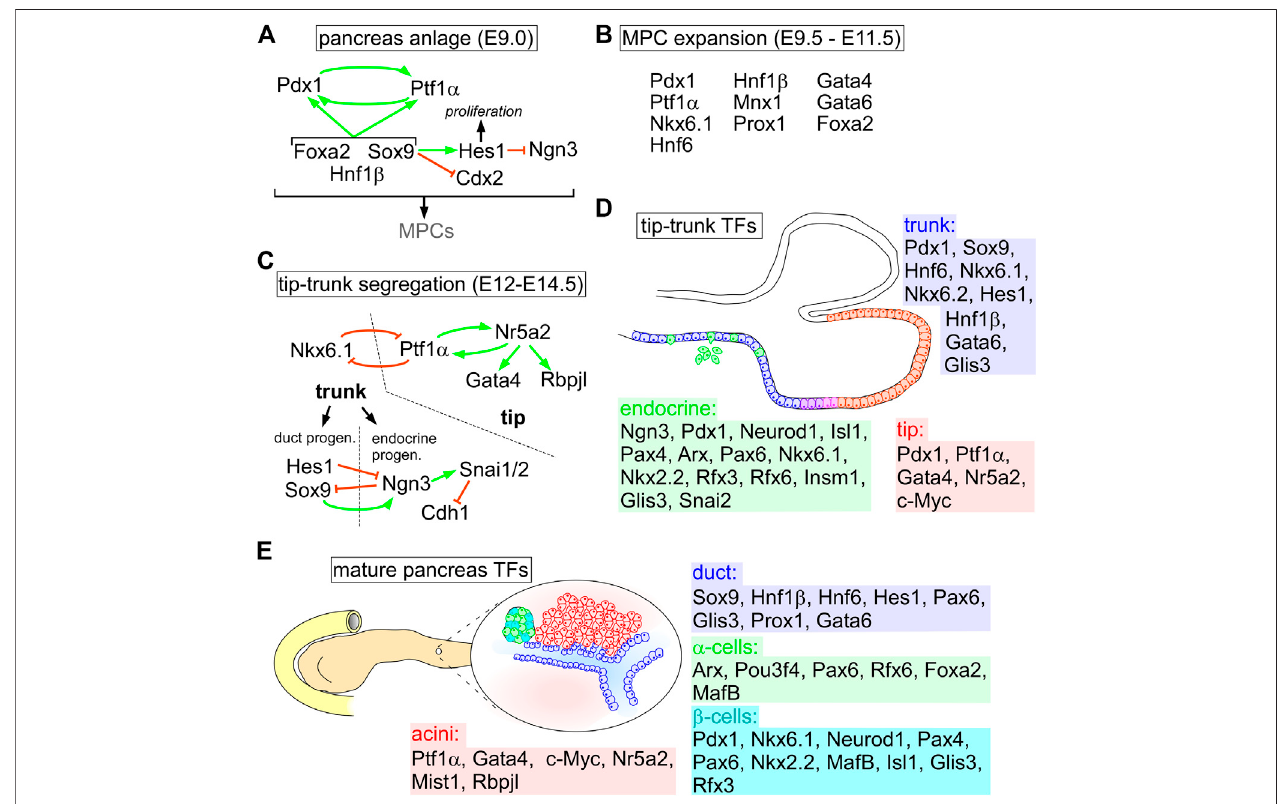
FIGURE 1 | Transcription factor networks orchestrating pancreas speci fi cation and homeostasis. (A) Early events to form the pancreas anlage and MPC speci fi cation. (B) TFs involved in expansion of the MPC pool during primary transition. (C) TF networks to de fi ne tip and bipotent trunk domains. In the trunk additional networksareestablishedforendocrineandductspeci fi cation. (D) Sketchoftip-trunkcelldistributioninthepancreasprogenitorshighlightingTFsactiveineachdomain ’ s networks. (E) overview on TFs of each cell compartment in the adult pancreas during homeostasis.